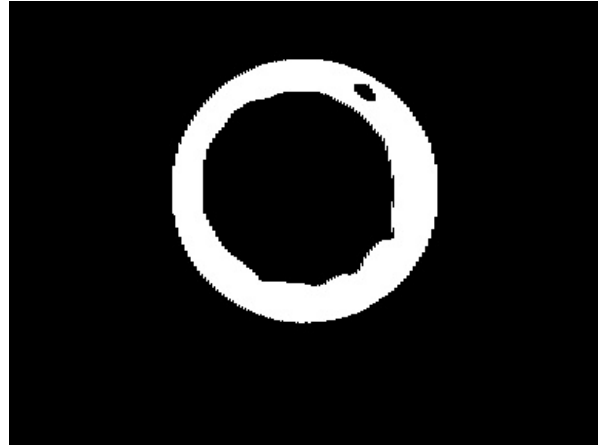
Figure 6. Image of the cap after removing the noise.